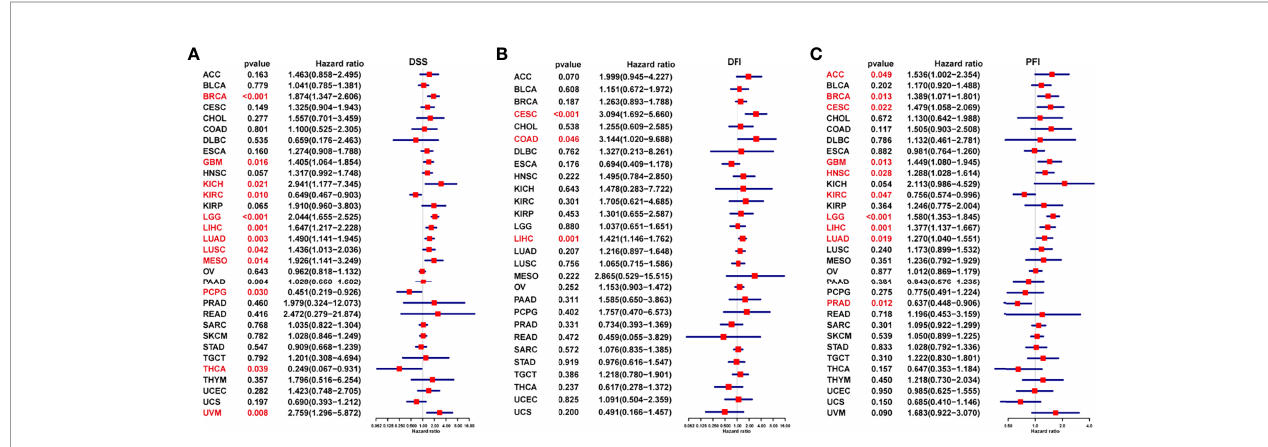
FIGURE 4 | Prognostic value of FUCA2 based on a TCGA dataset in pan-cancer. Forest plots showing results of Univariate Cox Regression analysis for (A) DSS, (B) DFI, and (C) PFI. Red color represents signi fi cant results (p < 0.05).